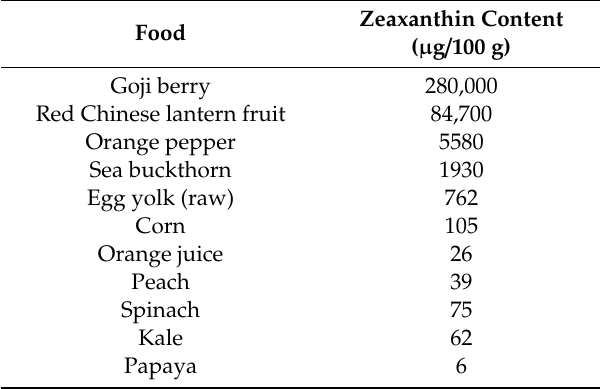
Table 1. Dietary sources of zeaxanthin.